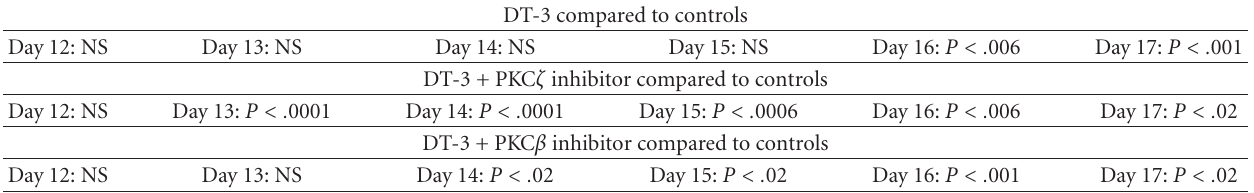
Figure 3: Two days after plating each EB into a well of a 24-well plate (nine days after removal of LIF), DT-3 and DT-3 + PKC β inhibitor, or DT-3 + PKC ζ inhibitor were added to di ff erent EBs. Carrier alone and untreated EBs were used as controls. EBs were then analyzed for beating two days later (Day 11 post LIF removal). As an added control, all four authors routinely performed blind counts of EBs to decrease subjectiveness. Discrepancies between authors were rare, but when they occurred, the morphology observed by the majority of authors was used as the data point. (a) Inhibiting PKG alone or in combination with PKCbeta or zeta resulted in significantly more EBs with at least one beating area when compared to controls. Significance is shown in Table 1 at each time point. The combination of DT-3 + PKCbeta or zeta inhibitors revealed in a trend towards more EBs that had at least one beating area when compared to DT-3 alone. Significance ( P < . 05) was attained on Day 14. (b) Inhibiting PKG alone or in combination with PKCbeta or zeta resulted in significantly more beating areas within EBs when compared to controls. Significance is shown in Table 2 at each time point. (c) A typical Day 14 EB outgrowth that has been subjected to DT-3 and PKCbeta specific inhibitor. NB = nonbeating area, B = beating area. Arrows depict the directional flow of contraction of the larger beating area. Scale bar = 100 μ meter. The number of EBs analyzed for both (a) and (b) is depicted below their specific treatment (e.g., n = 211 EBs for DT-3 treatment). Table 2: Significance comparing treated groups to controls (for data points in Figure 3(b)) number beating areas. NS: no significance. DT-3 compared to